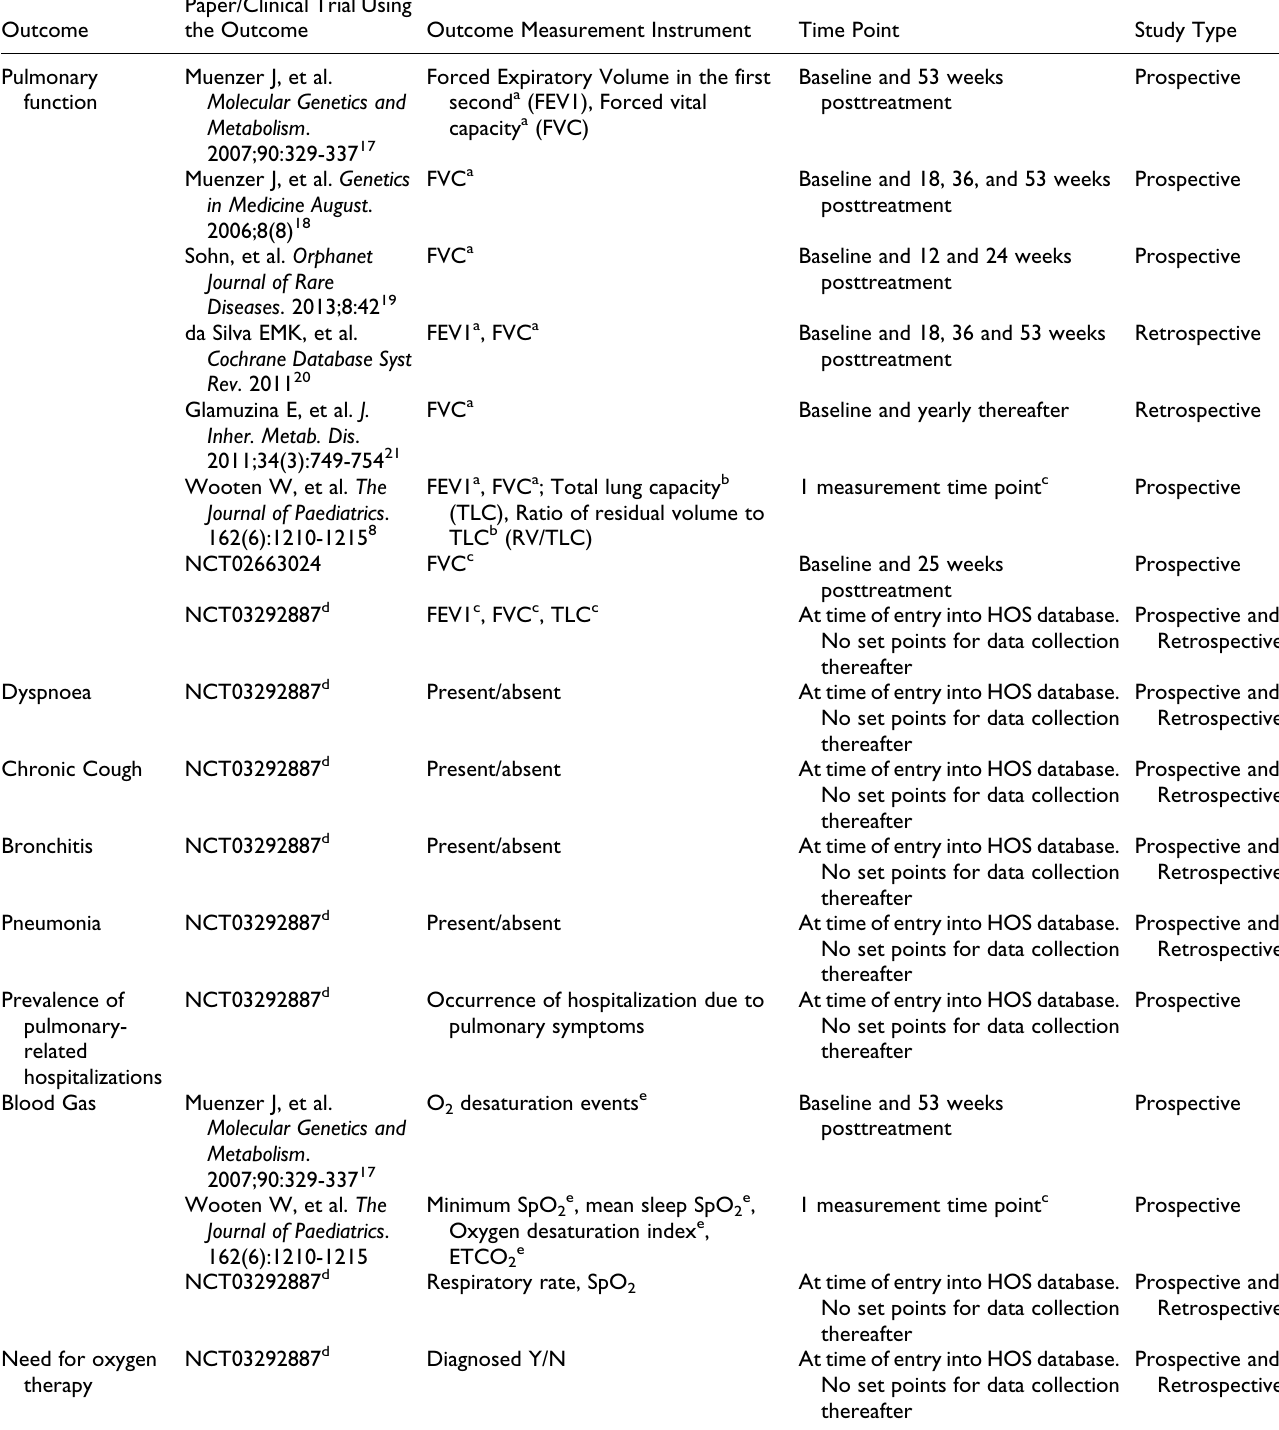
Table 2. Long-list of outcome measures and corresponding outcome measurement instruments